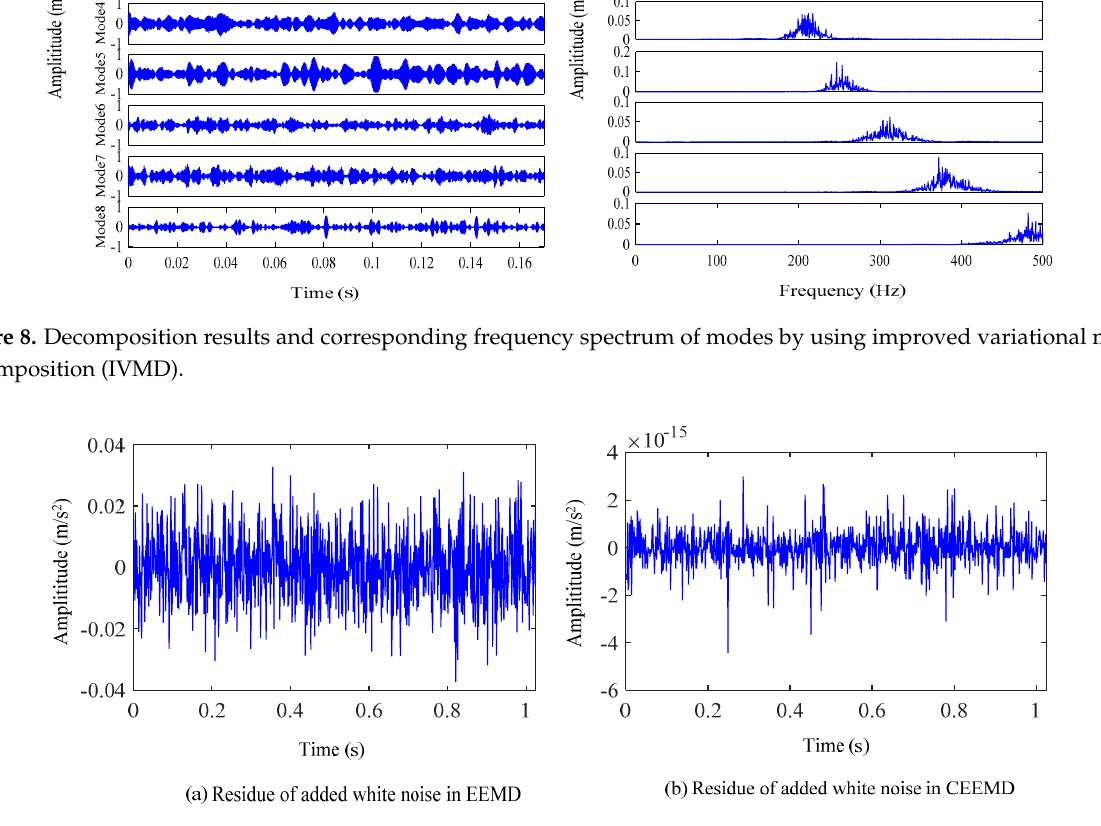
Figure 10. Envelope spectrum of optimal component by using EMD. Figure 11. Envelope spectrum of optimal component by using EEMD. Figure 12. Envelope spectrum of optimal component by using CEEMD.